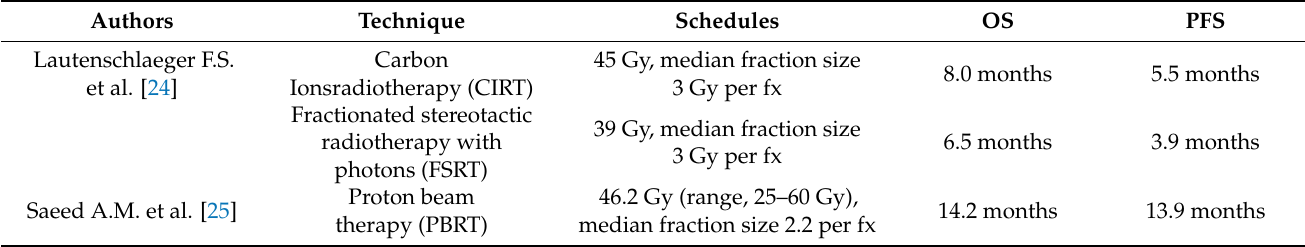
Table 1. Differences in terms of overall survival (OS) and progression-free survival (PFS) between carbon ions radiotherapy, photon beams radiotherapy and proton beam